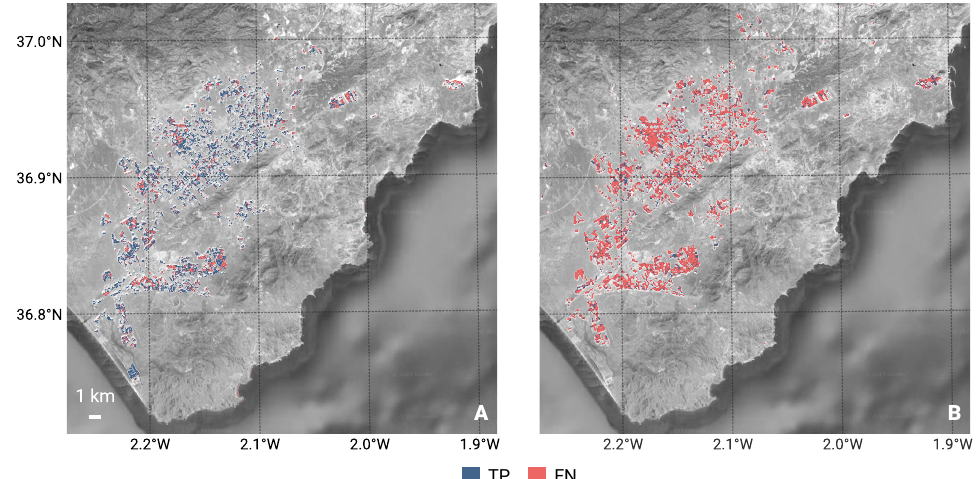
Figure 11. Classified pixels that depict greenhouse roofs of ( A ) PRISMA HYC and ( B ) Sentinel-2 MSI using a scene in Almería, southeast Spain. TP are true positives, i.e., PE, and FN are false